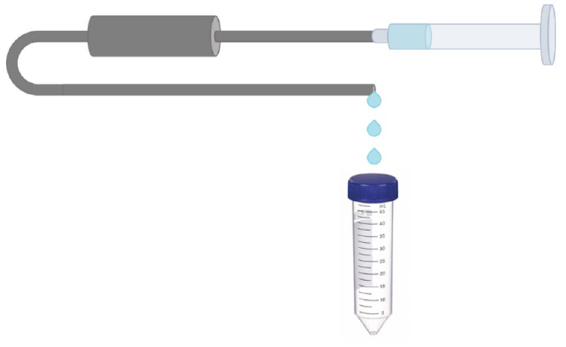
Figure 4. Example of the elution wash process of attaching a syringe of water to each trap and passing varying amounts of water through to a collection vessel.